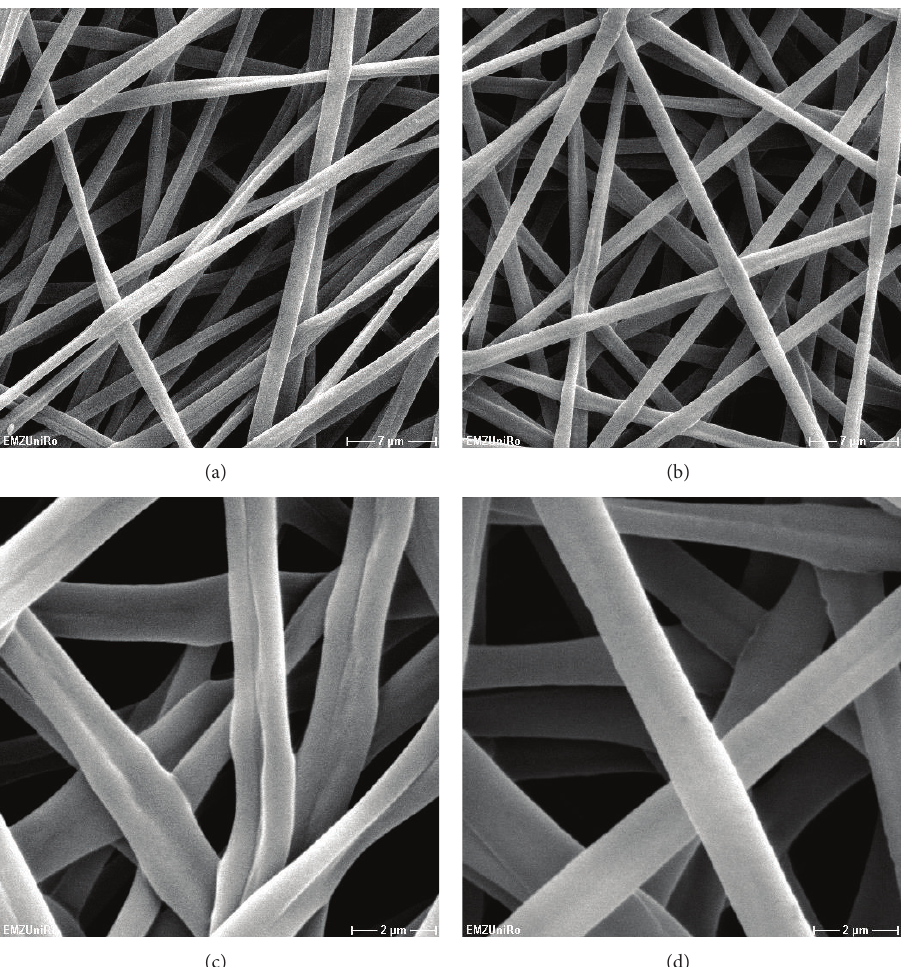
Figure 4: SEM images of untreated (left) and PPAAm-coated (right) electrospun PLA meshes (different magnification, upper row: × 3000, bar = 7 𝜇 m; lower row: × 10 000, bar = 2 𝜇